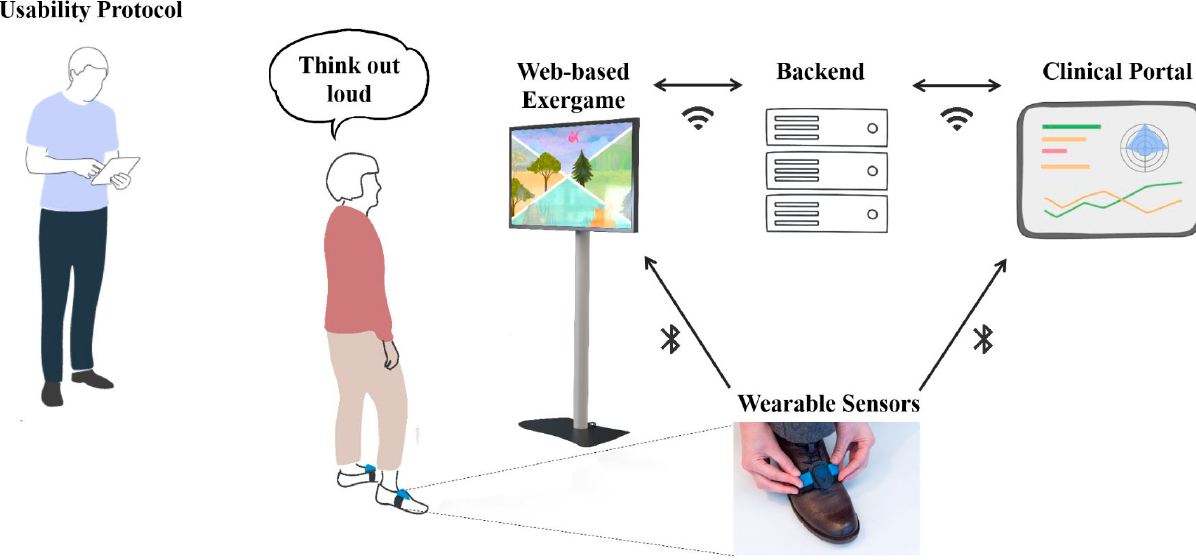
Figure 2. VITAAL system and exergame session setup. The VITAAL solution consists of a web-based exergame and a clinical portal. Both communicate with the backend via a wireless connection and with the sensors via Bluetooth. With the sensors placed on the feet, steps will be detected and real-time feedback within the game can be provided for cognitive and balance games. The participant is thinking out loud during the exergame session while the therapist observes and fills in the usability protocol.